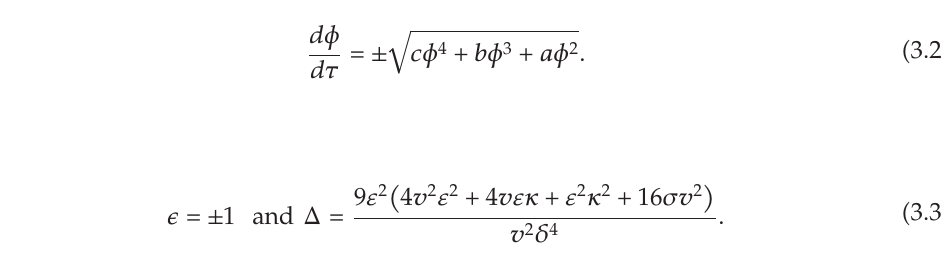
di ff erent kinds of exact traveling wave solutions of parametric type of (cid:2) 1.1 (cid:3) , see the following